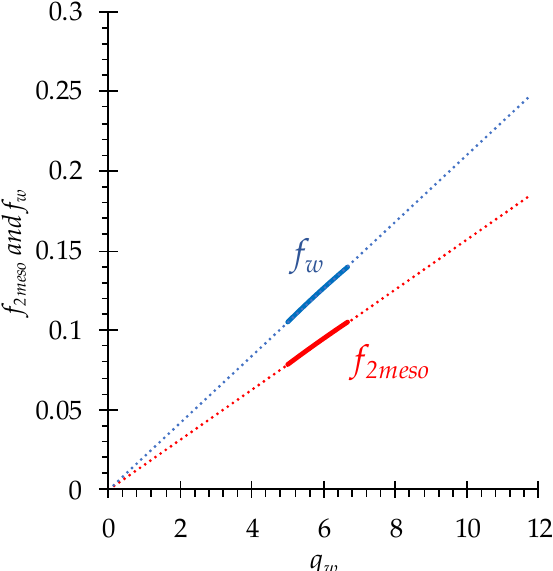
Figure 4. f 2 meso and f w as functions of the amount of free water, q w , in the MA-41 membrane. The range of q w and calculated f 2meso and f w values corresponding to the solution concentrations from 0.1 to 4 mol/L are shown by solid lines. Extrapolation of simulation data is shown by dots. With a decrease in the pore size, the ion mobility decreases due to an increase in the constraint of ion channels and an increase in the tortuosity of the ion pathways. According to Mackie and Meares [59], the effective value of the ion diffusion coefficient, D i , in the gel phase is determined by the expression